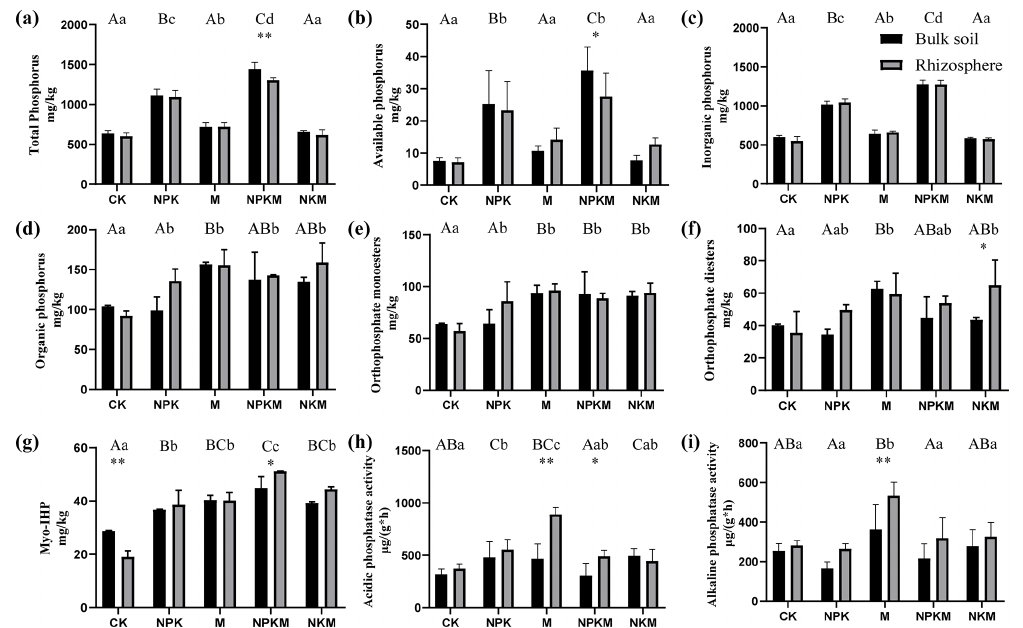
Figure 1. Different phosphorus forms and phosphatase activities in five treatments (CK, NPK, M, NPKM, NKM) and two sample types (rhizosphere and bulk soil): (a) total phosphorus, (b) available phosphorus, (c) inorganic phosphorus, (d) organic phosphorus, (e) orthophos- phate monoesters, (f) orthophosphate diesters, (g) Myo-IHP, (h) acidic phosphatase activity, (i) alkaline phosphatase activity. Significant differences between treatments in bulk soil are indicated by capital letters ( p < 0 . 05, n = 4). Significant differences between treatments in rhizosphere are indicated by lowercase letters ( p < 0 . 05, n = 4). Significant differences between rhizosphere and bulk soil are indicated by asterisks, where ∗ p < 0 . 05, ∗∗ p < 0 . 01 (Duncan’s test, n =